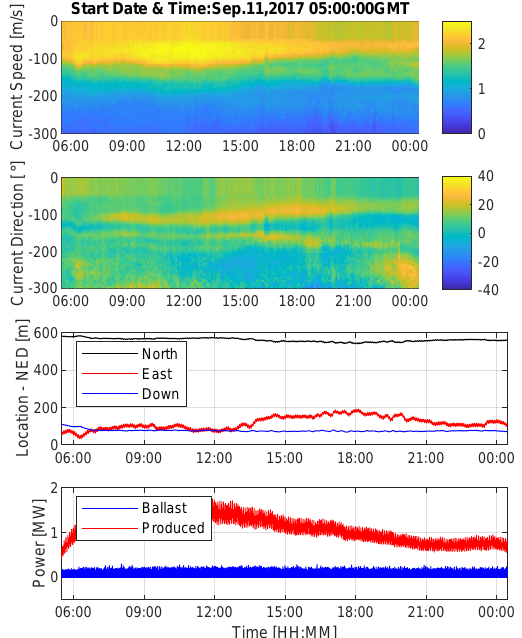
Fig. 9. Hurricane condition (September 11, 2017): time histories of the OCT’s states, i.e., Euler angle, location-NED, and power. buoyancy), and sensor models. Probable OCT faults